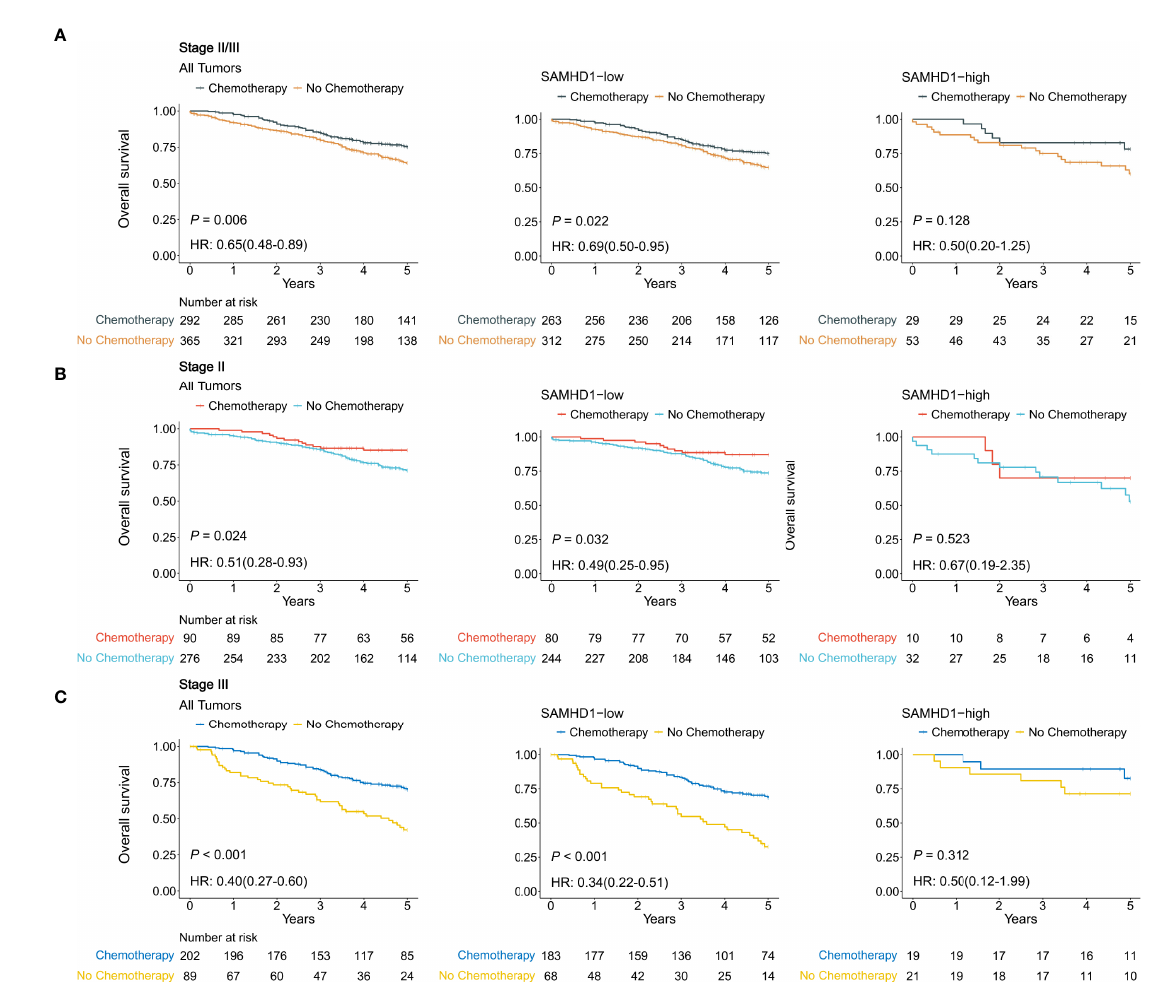
FIGURE 3 Relationship between SAMHD1 expression and the bene fi t from adjuvant chemotherapy using Gene Expression Omnibus data. (A) Patients with stage II and stage III disease. (B) Patients with stage II disease. (C) Patients with stage III